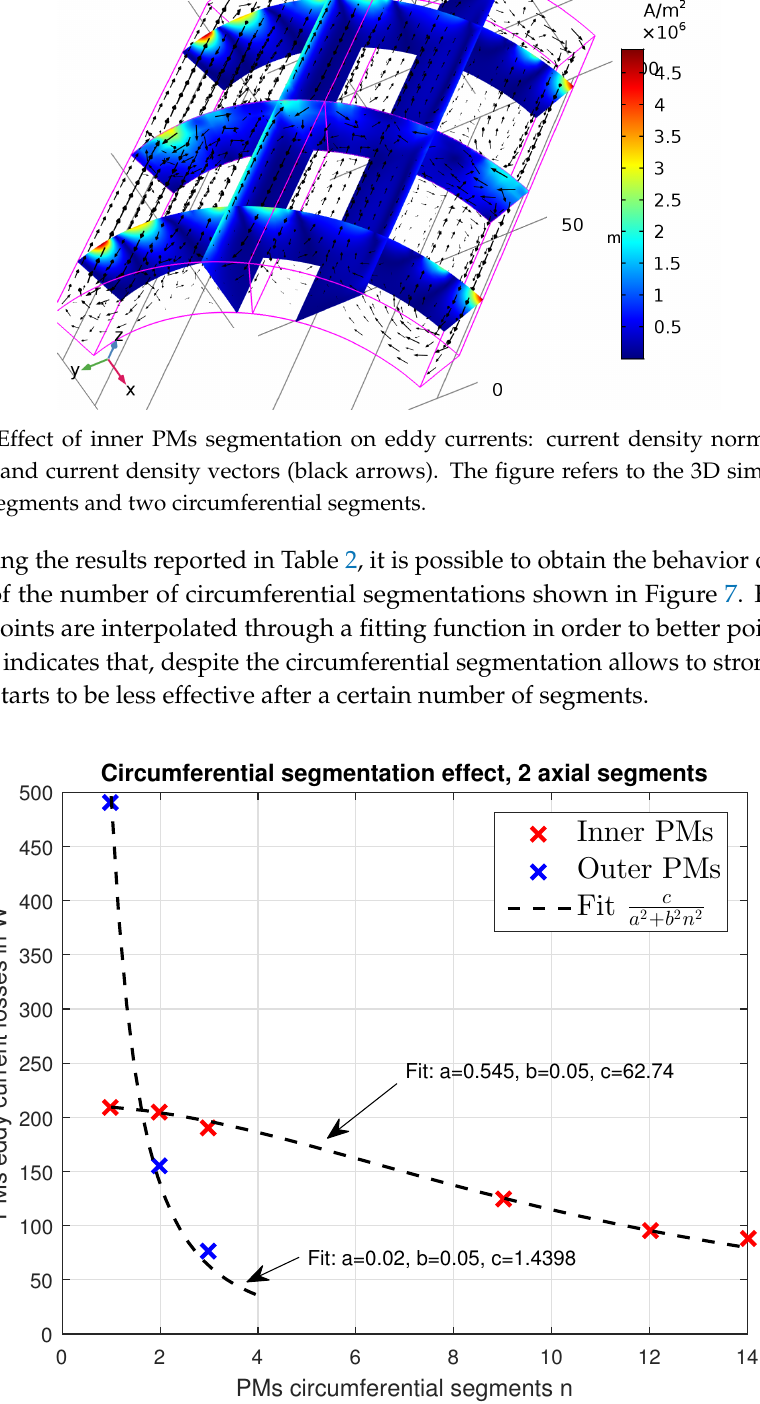
Figure 8. Circumferential segmentation effects on PMs losses with two axial segments. The loss fit is based on the equation P = c . The inner magnets fit provides a = 0.545, b = 0.05, c = 62.74 a 2 + b 2 ∗ n 2